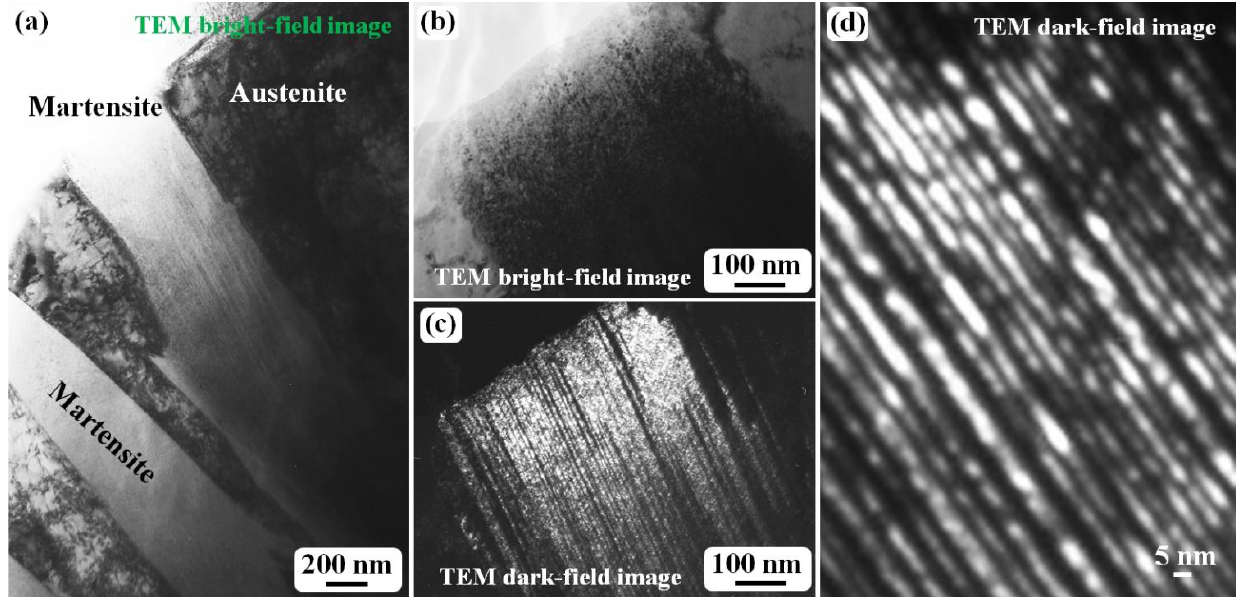
Figure 1. TEM images obtained from the water-quenched cast iron plates after austenitizing at 1150 °C for 1 h. ( a ) General bright field image revealing the martensite structure. ( b ) Bright field micrograph revealing twin contrast in martensite structure. ( c ) Dark field image revealing the twin size and morphology. ( d ) An enlarged dark field image revealing an ultra-high density of the twins.